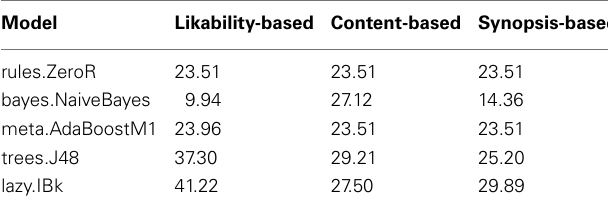
Table 7 | Results in percent